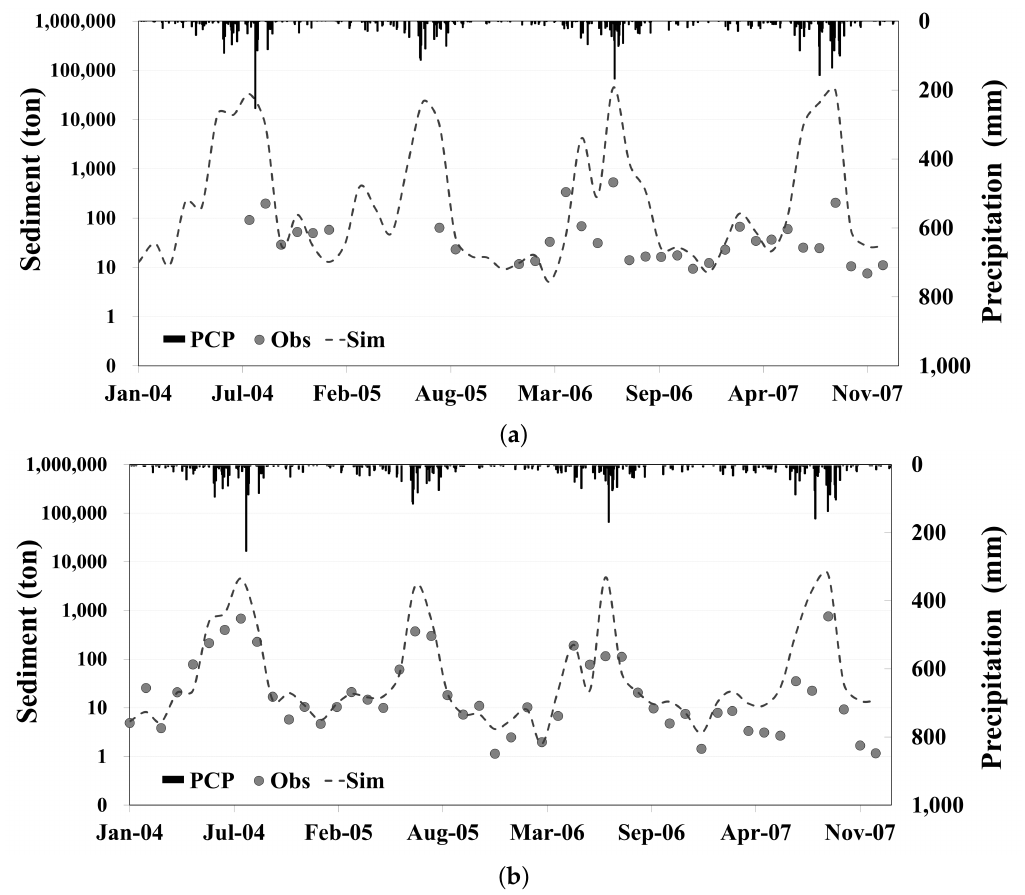
Figure 6. Time series plots for monthly sediment yield simulation: ( a ) Hwang River “A”; ( b )